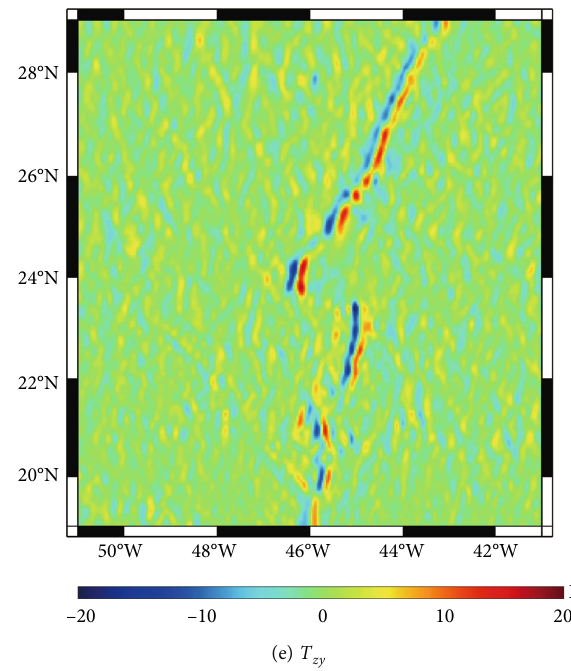
Figure 12: Gravity gradient reference map of the calculation area.